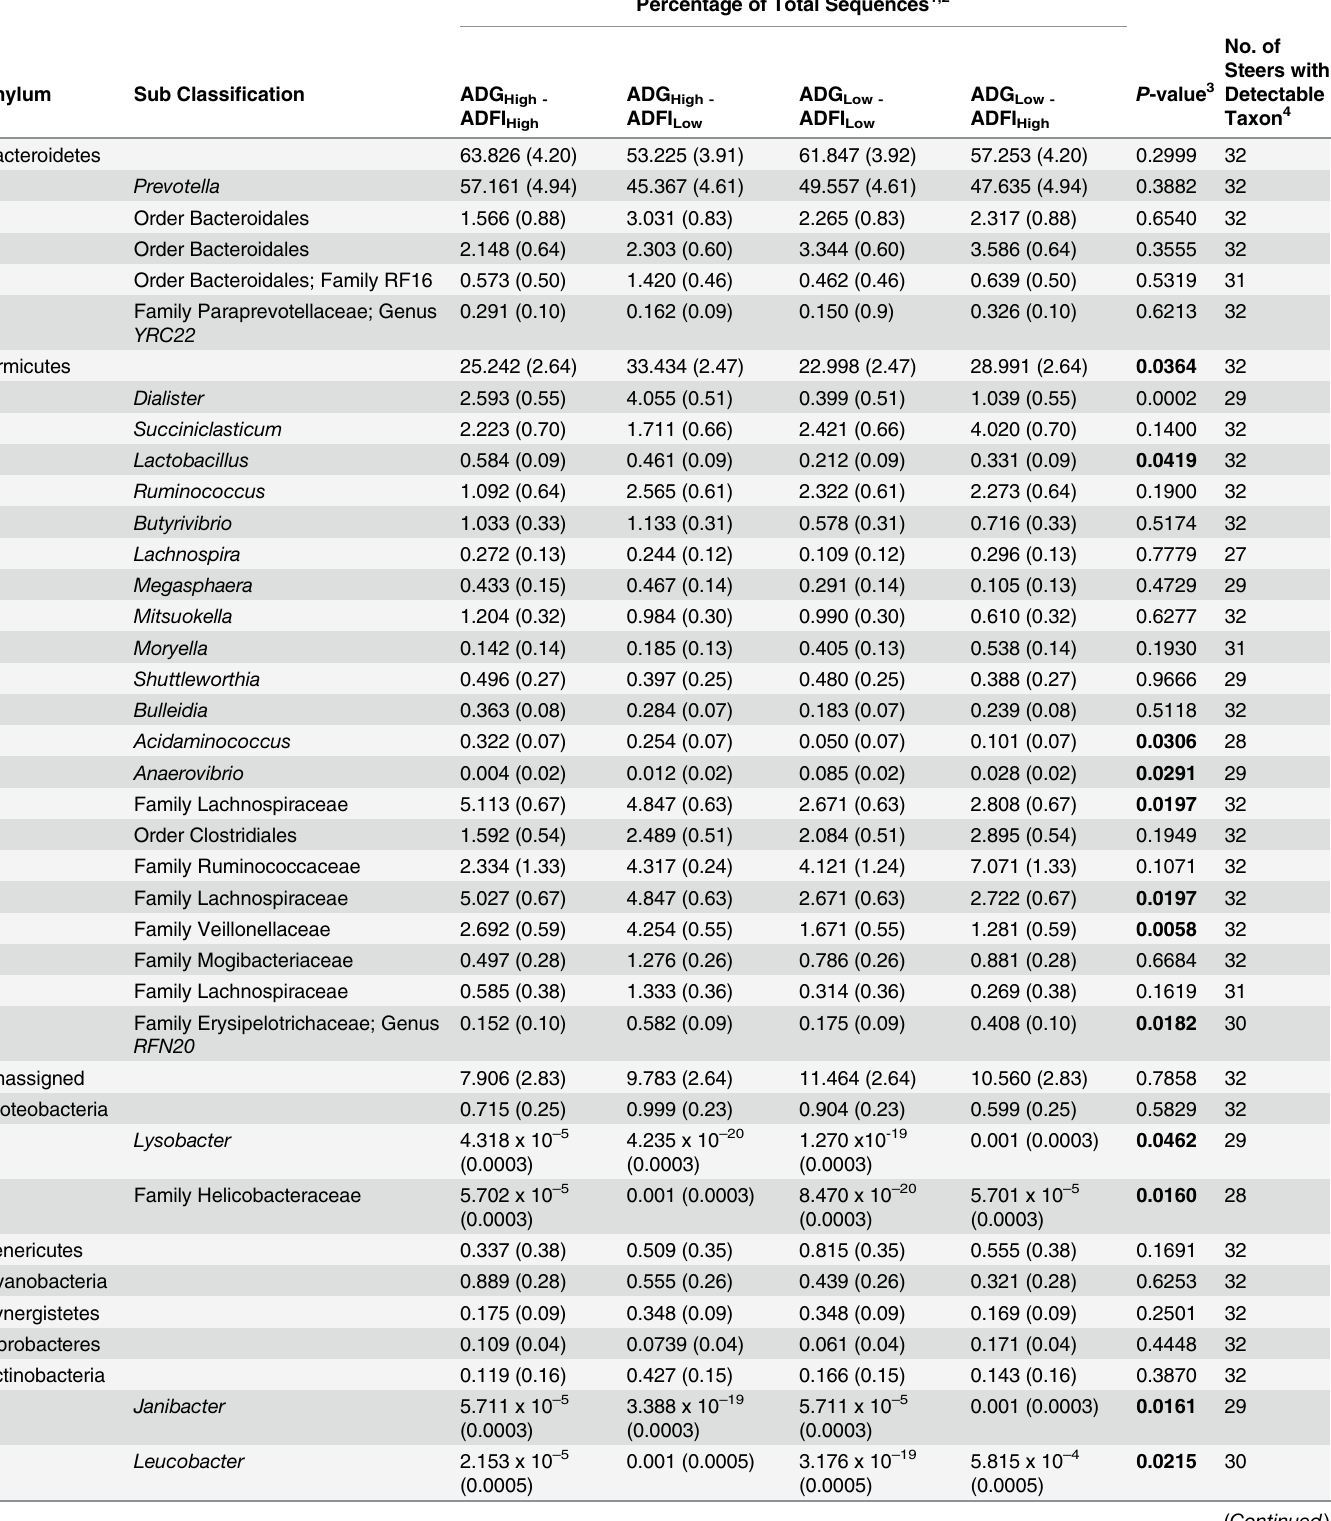
Percentage of Total Sequences